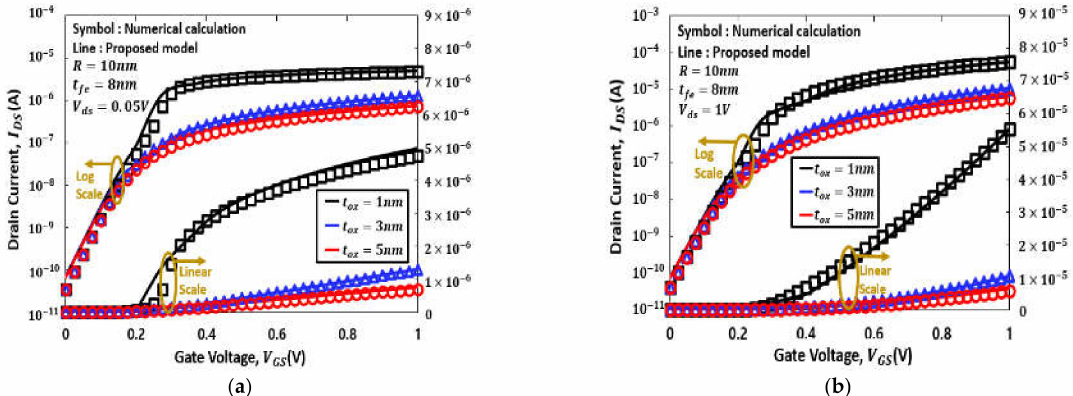
Figure 5. Result of drain current versus gate-to-source voltage when oxide thickness varies with t ox = 1, 3, and 5 nm; ( a ) low drain bias; ( b ) high drain bias.